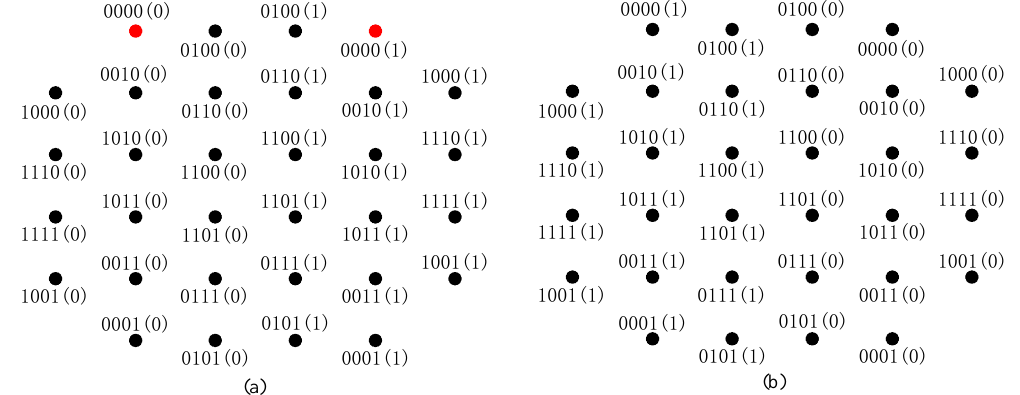
Figure 3. An example of the SELS. ( a ) Labeling scheme L 1 . ( b ) Labeling scheme L